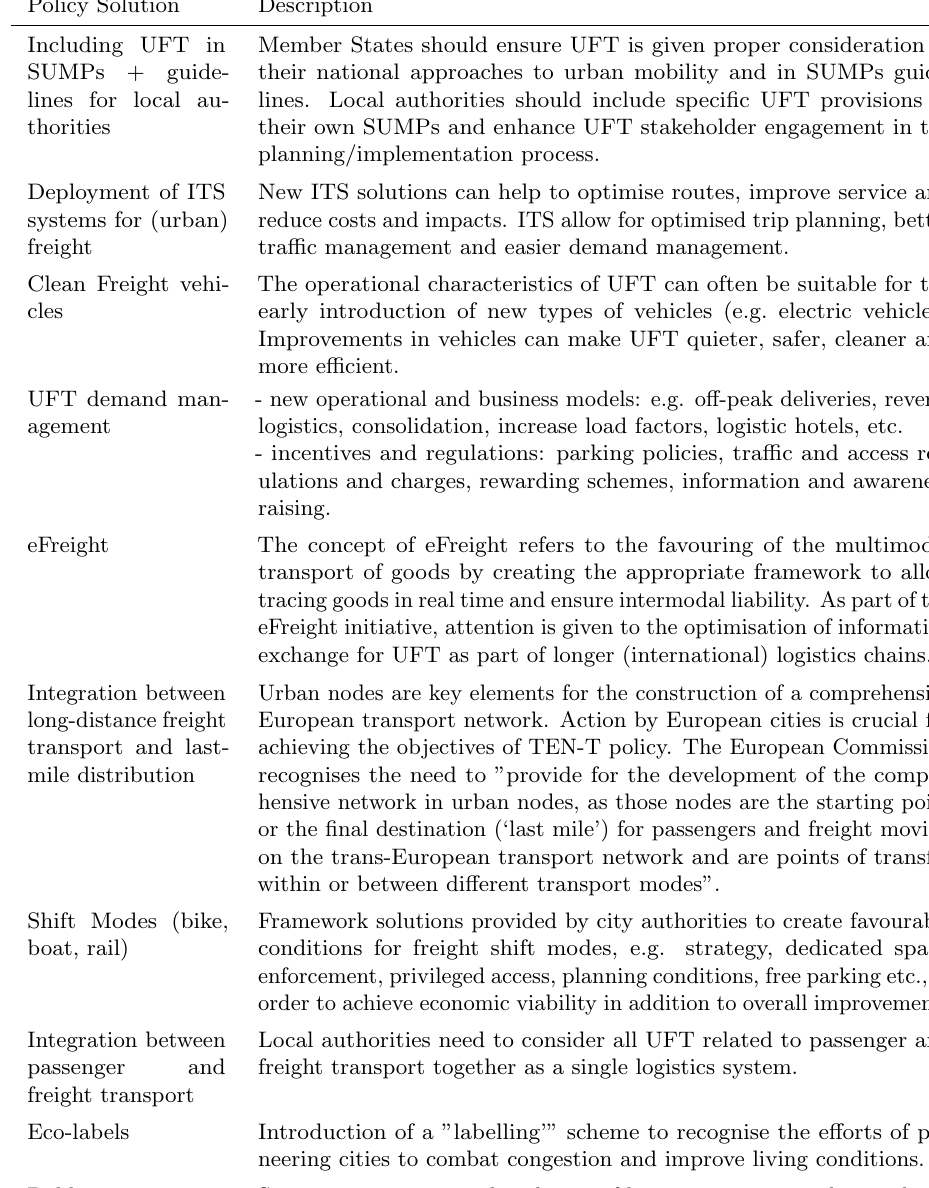
Table 1: Selected UFT policy solutions and their